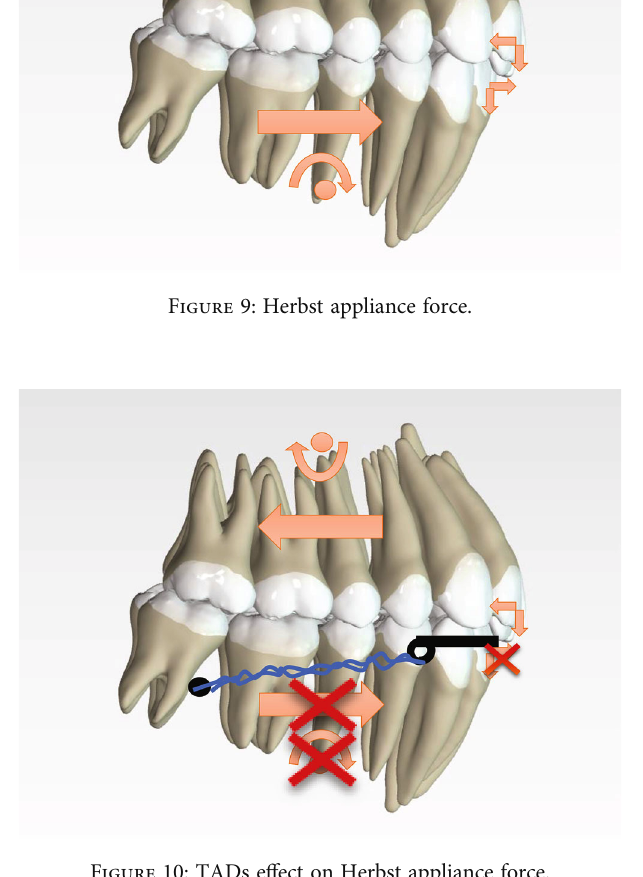
Figure 10: TADs e ff ect on Herbst appliance